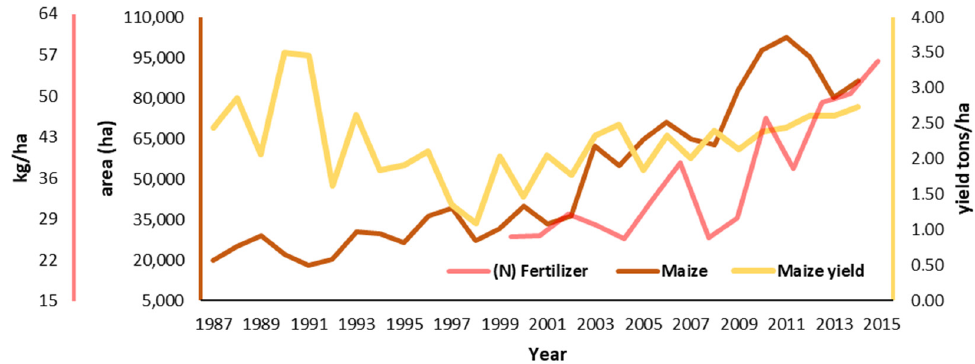
Figure 13. Area under maize, maize yield (Copperbelt) and fertilizer use (Zambia). Data taken from Zambia Central Statistical Office.